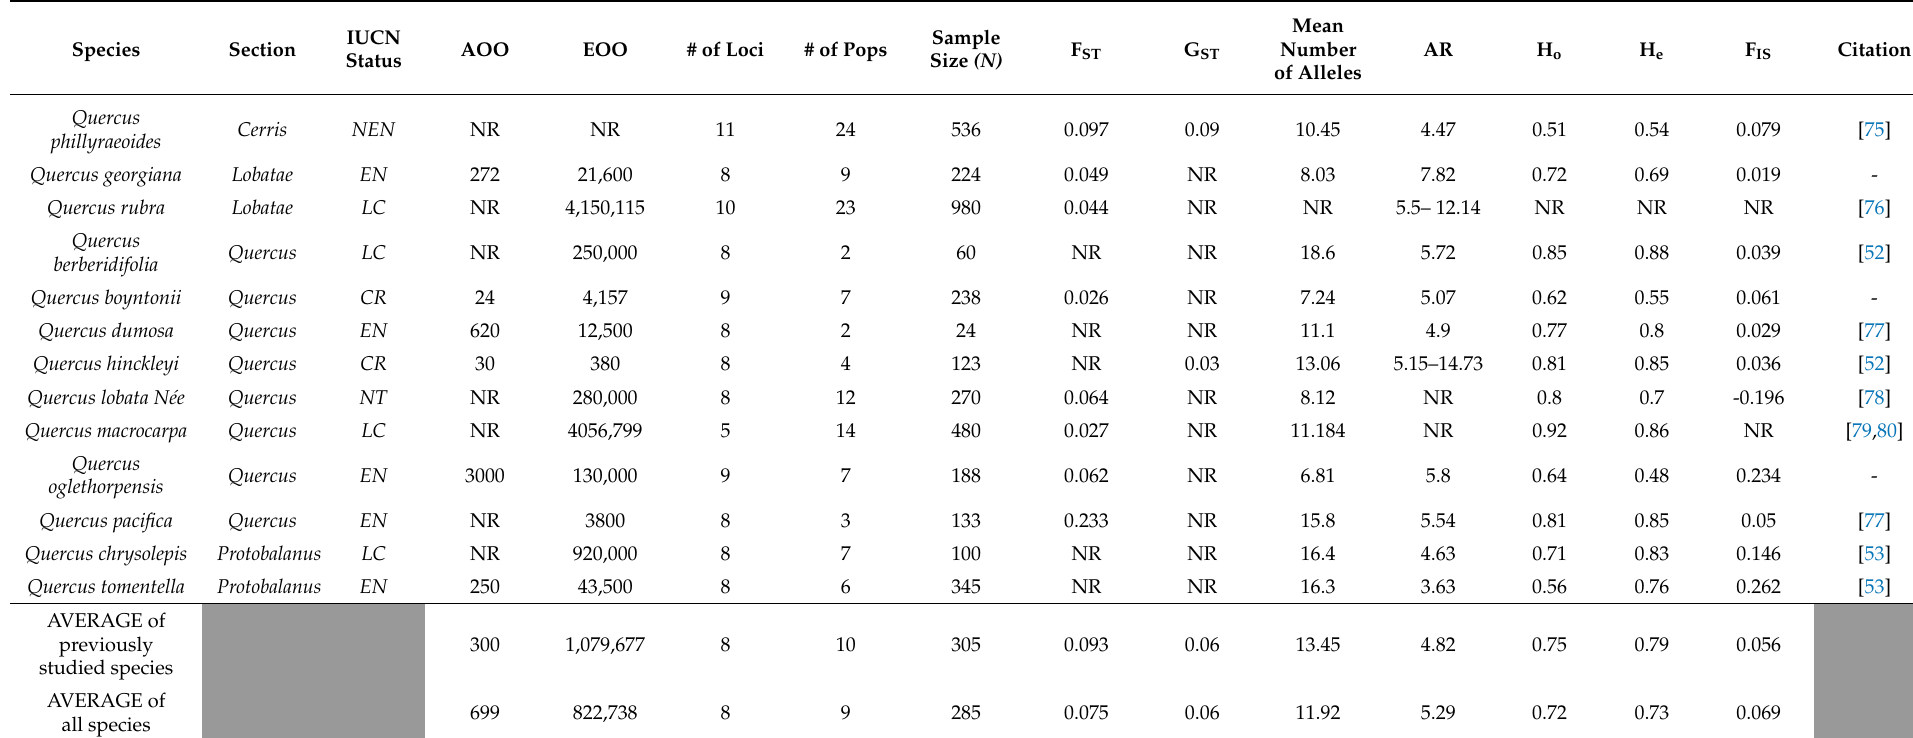
Table A2. Literature review and comparison of previously published population genetic studies of oak species and species accessed in this